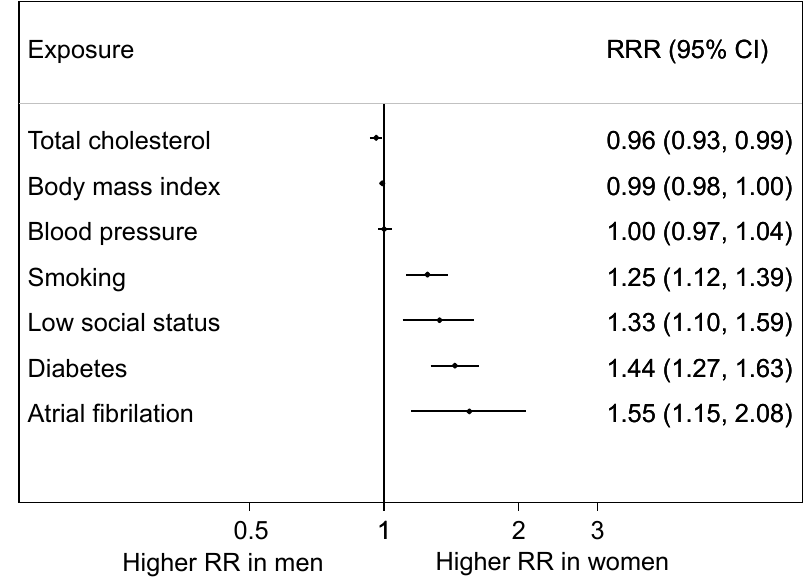
Figure 6. Women-to-men ratios of relative risks (RRRs) for coronary heart disease: pooled results from meta-analyses of numerous individual studies. Total cholesterol, body mass index and blood pressure were all measured continuously (i.e., the relative risks (RRs) are per unit increase); smoking signifies current versus not current; low social status is compared to high social status; diabetes and atrial fibrillation compare yes to no.